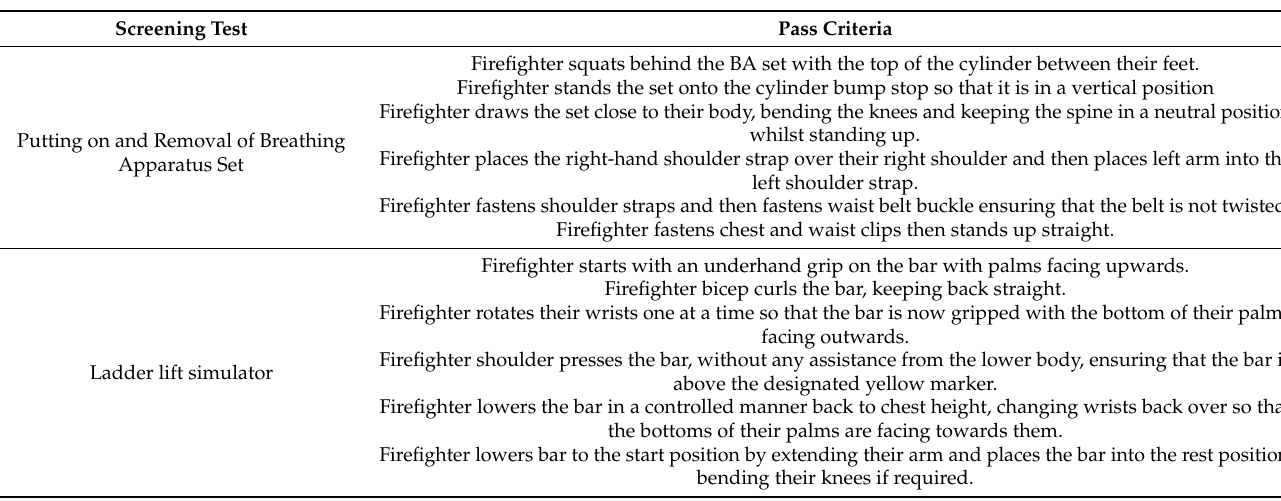
Table A1. Screening Video Criteria Form